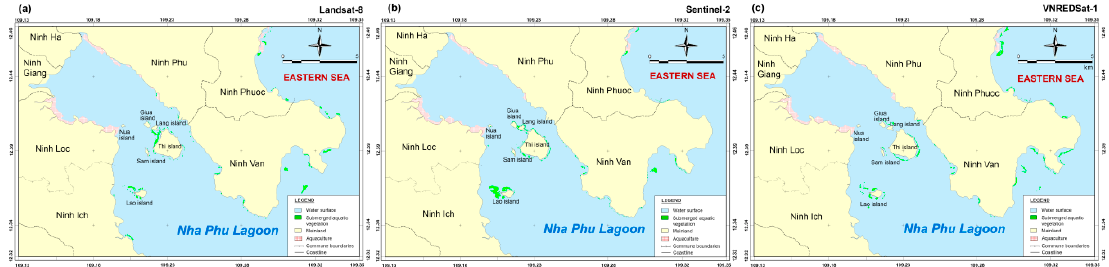
Figure 7. SAV distribution maps for Nha Phu Lagoon, using data from three satellites: ( a ) Landsat-8